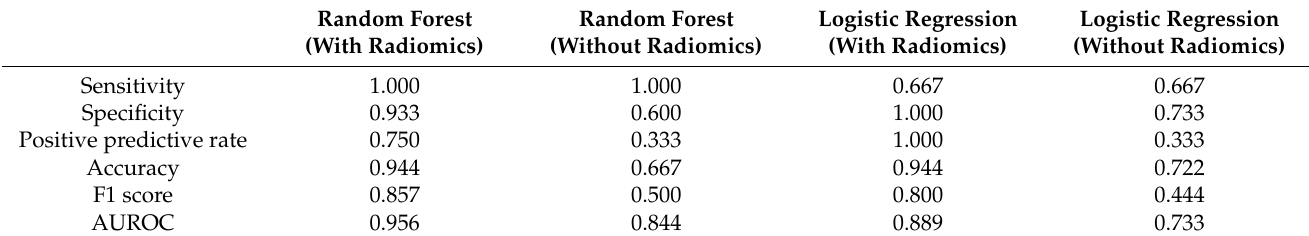
Table 3. Summary of sensitivity, specificity, and accuracy rates for prediction of RILD in the test set by random forest and logistic regression model for hepatocellular carcinoma treated with